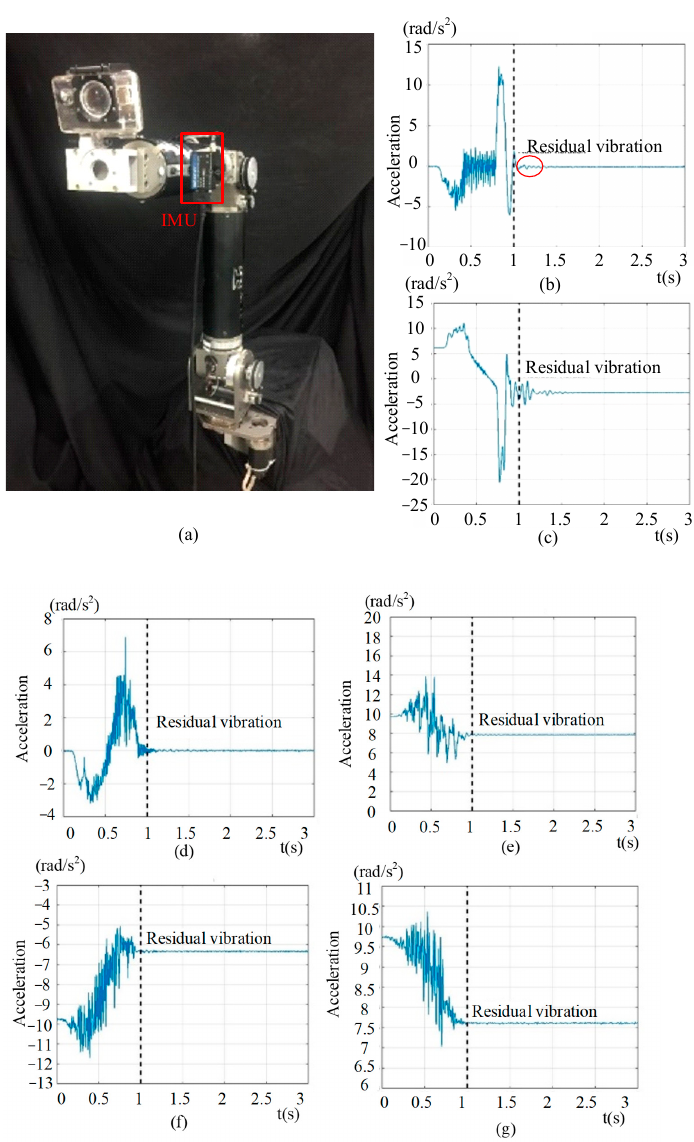
Figure 8. Experimental setup and data. ( a ) The installed IMU sensor is installed in joint 5. ( b – g ): Acceleration data for joints 1 to 6 rotated in the CCW direction. (( b ): joint 1, ( c ): joint 2, ( d ): joint 3, ( e ): joint 4, ( f ): joint 5, ( g ): joint 6).